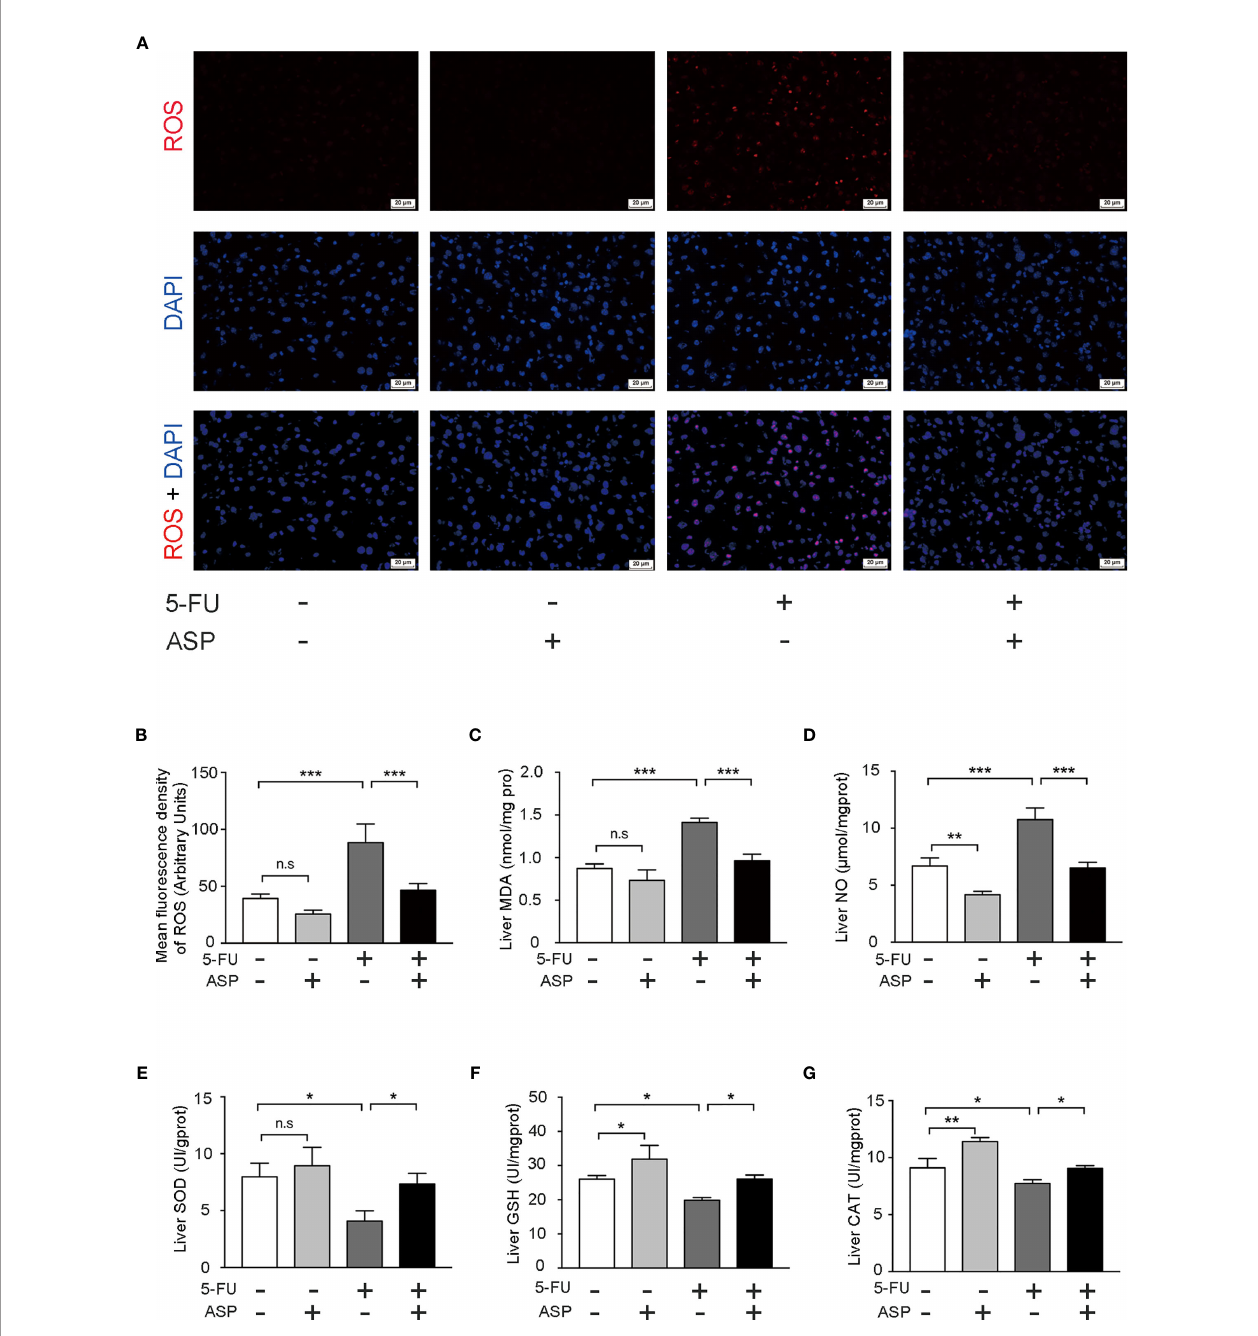
FIGURE 4 | ASP treatment relieved 5-FU-induced oxidative injury in mice. (A) The level of ROS was determined (magni fi cation, × 400, scale bar, 20 m m). (B) The intensity of fl uorescence was quanti fi ed under microscopy and analyzed using the image analysis program ImageJ ( n = 6/group). (C, D) ASP rescued the increased MDA and NO content caused by 5-FU in mice liver ( n = 3/group). (E – G) ASP rescued the decreased levels of SOD, GSH, and CAT caused by 5-FU in mice liver ( n = 3/group). * p < 0.05; ** P < 0.01; *** p < 0.001. n.s., not statistically signi fi